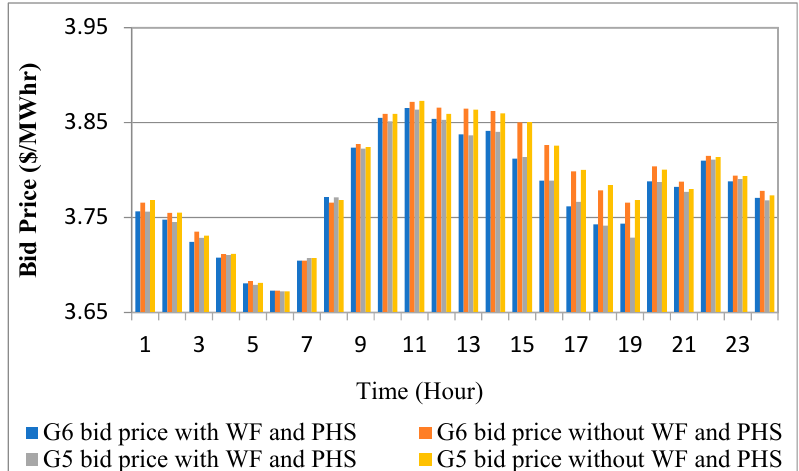
Figure 9. Bid price for G 23 and G 27 for 24 h scheduling period.